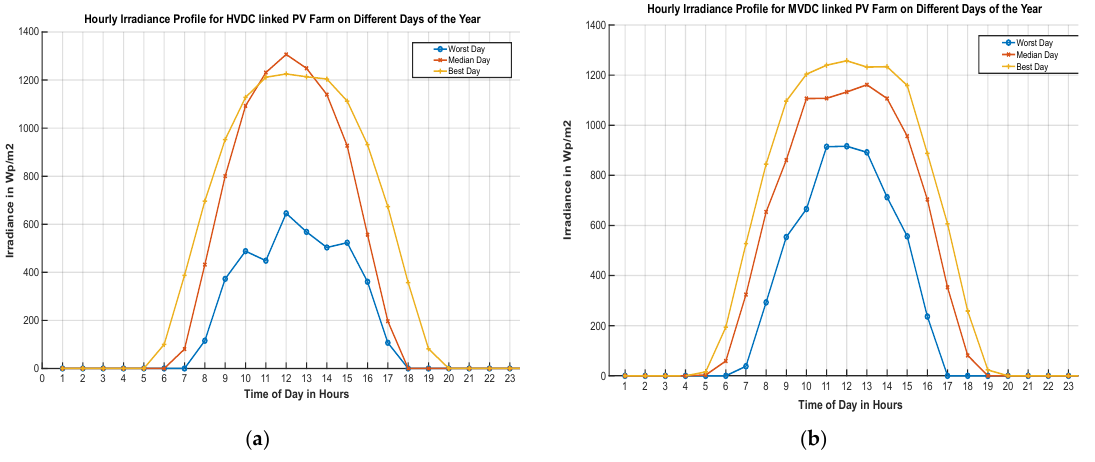
Figure 8. PV farm s’ irradiation profiles for different days of sunshine. ( a ) For the ID#2 HVDC-con- nected Rexford 1 and 2 farm; ( b ) for the ID #1 MVDC-connected Mount Signal 1, 2, 3